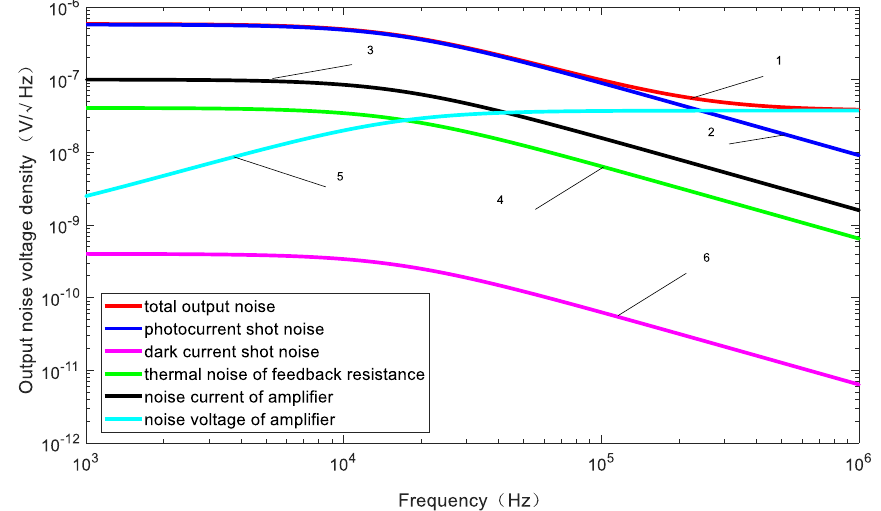
Figure 6. The model results of the noise components voltage density when the amplifier is LT1028: 1. total output noise, 2. photocurrent shot noise, 3. noise current of amplifier, 4. thermal noise of feedback resistance, 5. noise voltage of amplifier, 6. dark current shot noise.